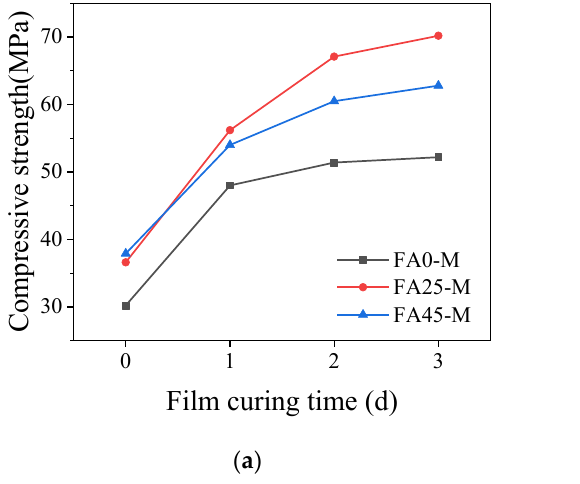
Figure 5. The 28 d mechanical strength under different film curing times, ( a ) Compressive strength and ( b ) Flexural strength. and ( b ) Flexural strength.